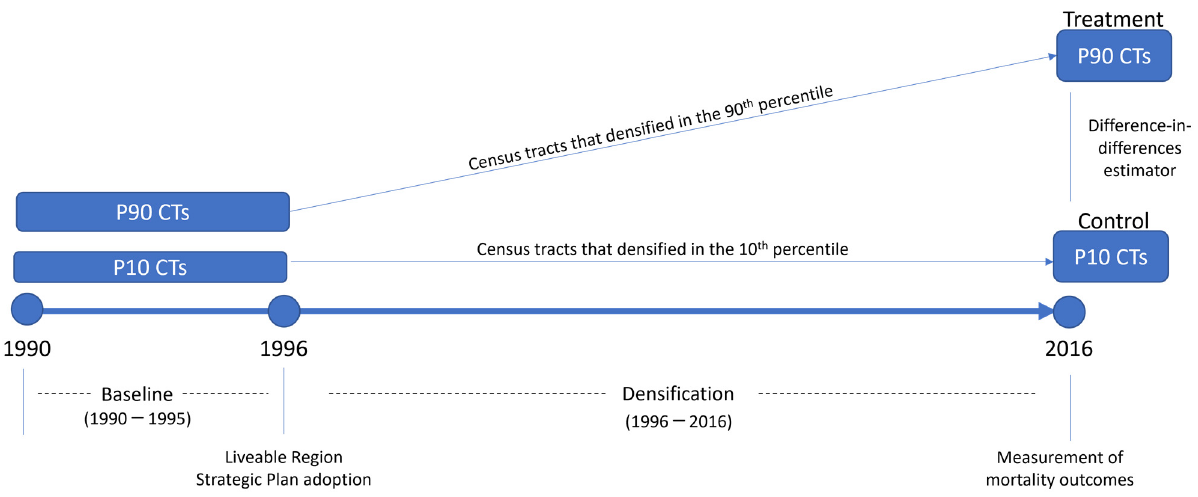
Figure 1. Study design of treatment (P90 CTs) and control (P10 CTs) groups.